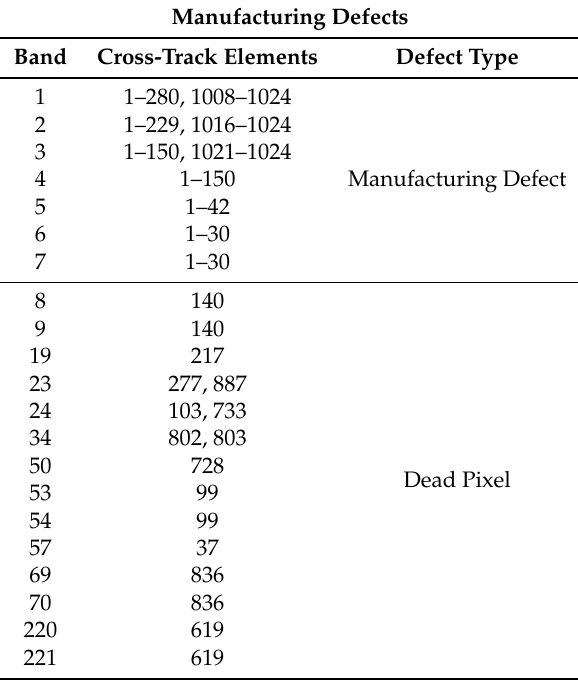
Table 11. Pixel defects on the DESIS chip (unbinned